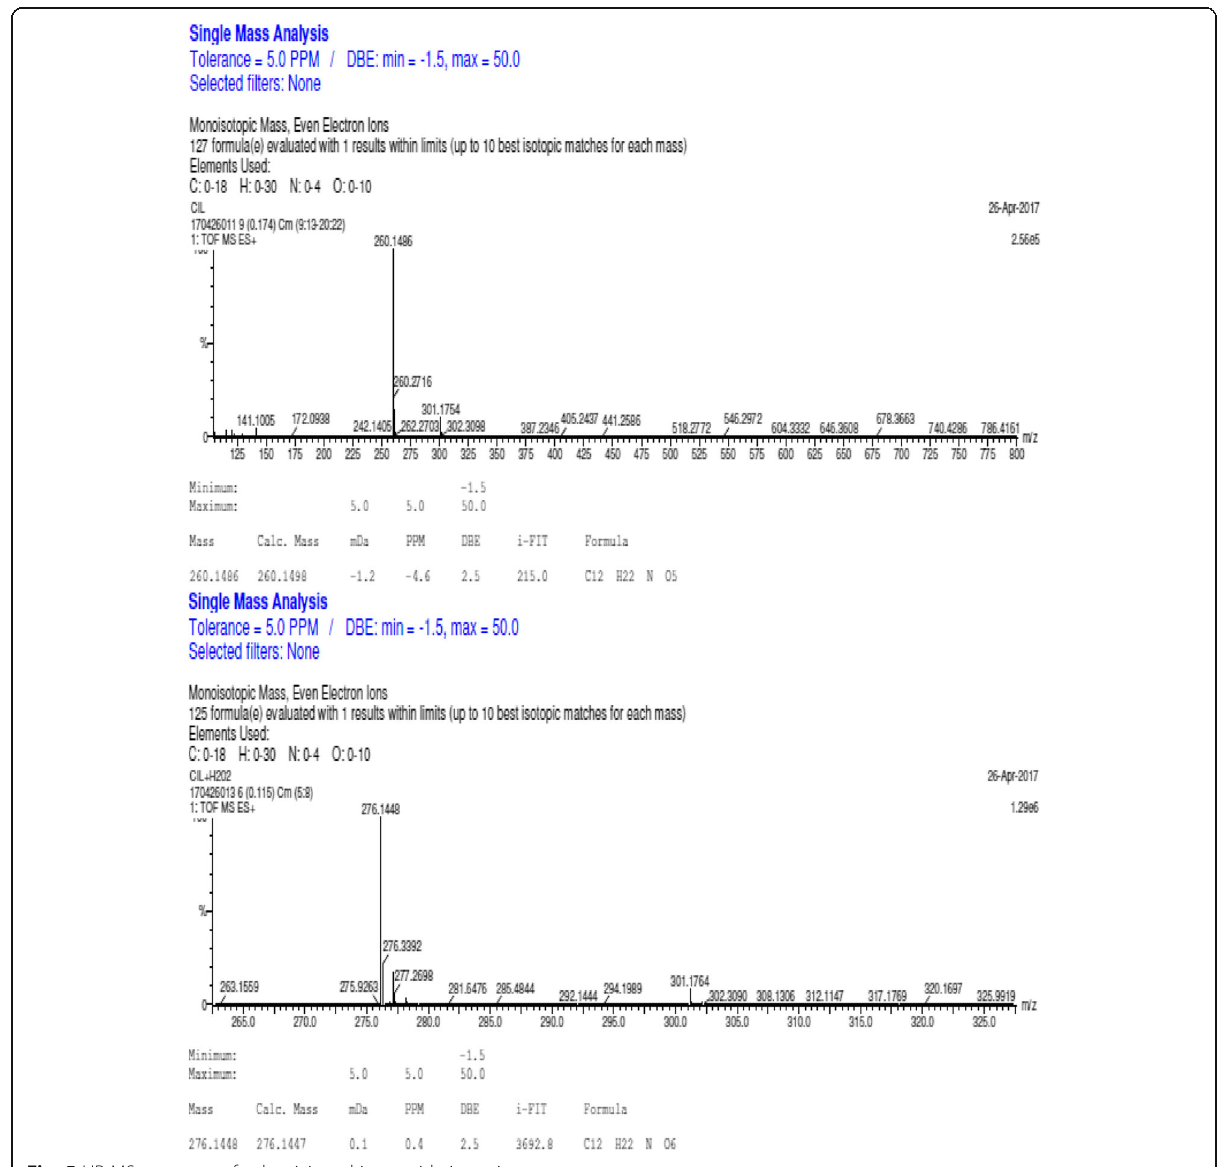
Fig. 5 HR-MS spectrum of celgosivir and its n-oxide